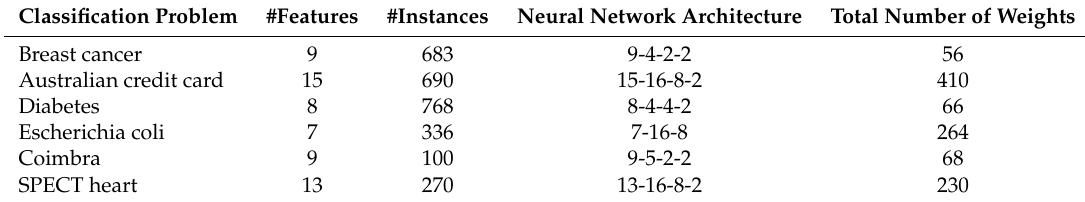
Table 1. Brief description of datasets and neural network architectures used in our study. Classification Problem #Features #Instances Neural Network Architecture Total Number of